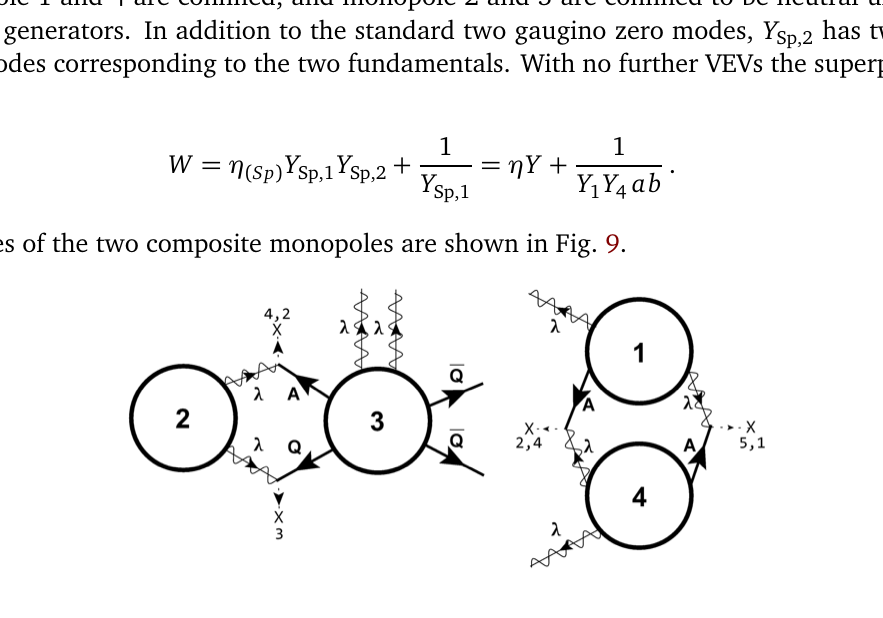
. The antisymmetric a